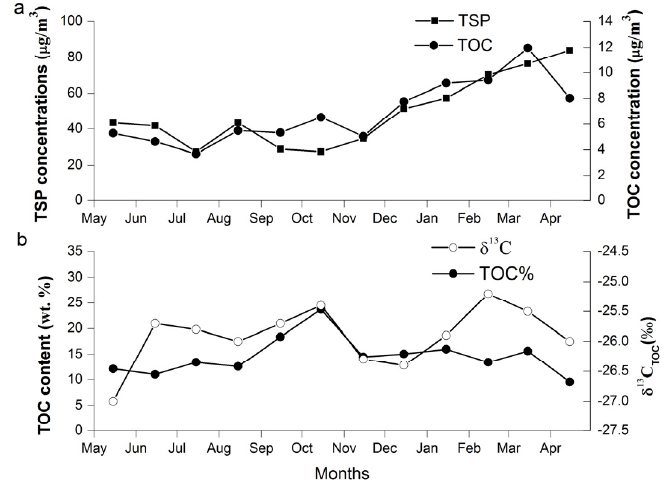
Figure 2. Temporal variations in bulk characteristics of ambient air aerosols in south coastal Xiamen. ( a ) Total suspended particulate (TSP) and total organic carbon (TOC) concentrations; ( b ) TOC contents (dry weight relative to TSP) and their stable carbon isotopic composition.